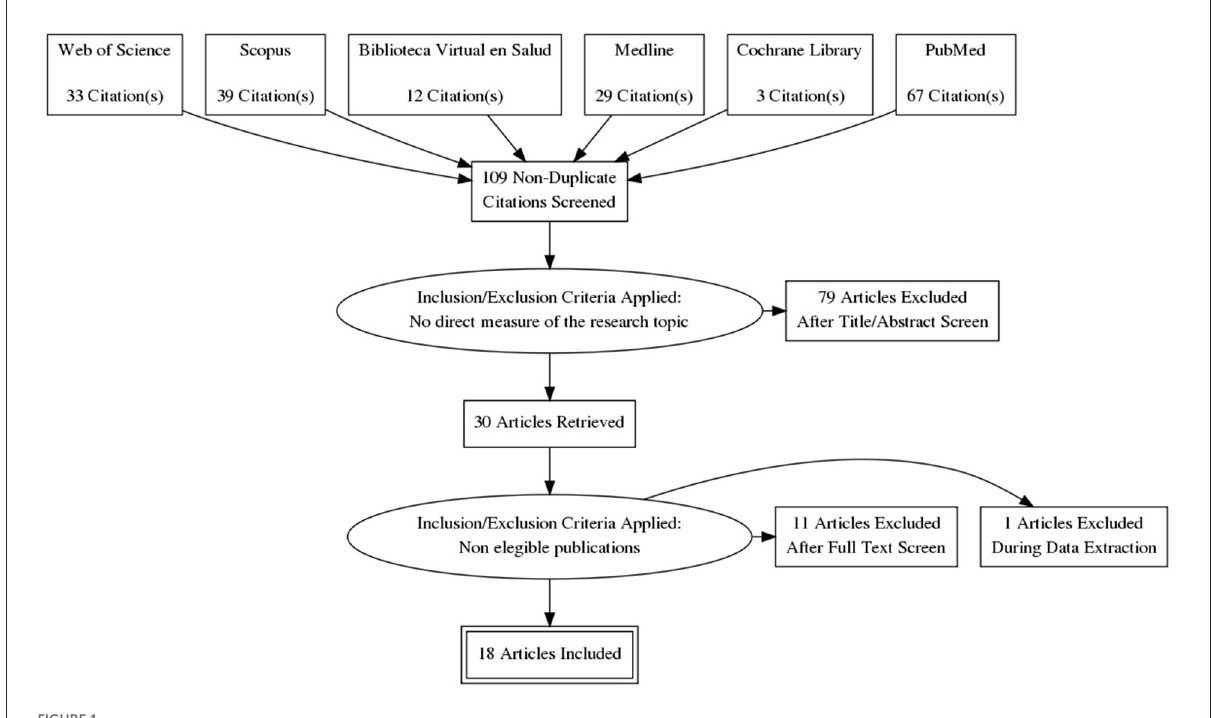
FIGURE1 PRISMA diagram for this systematic